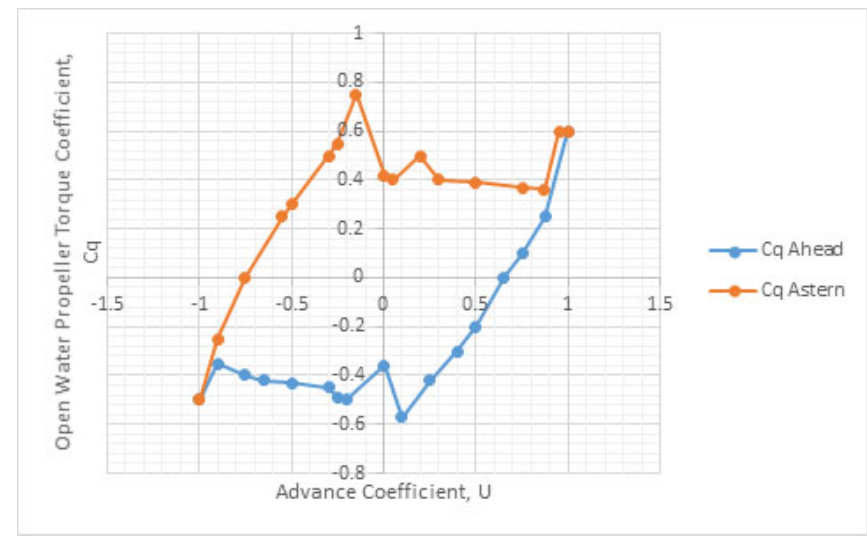
Figure 12. Shaft torque coefficient vs. advance coefficient.